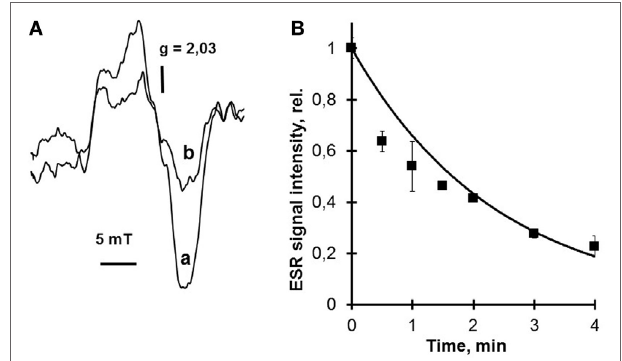
FigURe 1 | Photolysis of cytochrome c nitrosyl complexes. This figure proves the photosensitivity of heme nitrosyl complexes to low power laser radiation. The electron spin resonance (ESR) signals of cytochrome c nitrosyl complexes before and after He–Cd laser (442 nm) irradiation in the air are presented in this figure. The ESR signal of cytochrome c nitrosyl complex shown in panel (A) completely corresponds to hemoprotein nitrosyl complex signal and has g factor 2.03 (20). Irradiation of cytochrome c nitrosyl complexes by He–Cd laser in the air results in nitrosyl complex photolysis and the corresponding decrease of nitrosyl complex ESR signal (B) . Moreover, nitrosyl complex photolysis is accompanied with free nitric oxide (NO) release (data not shown) (18). To detect the NO release, the nitronyl– nitroxyl spin trap can be used. (A) ESR spectra of cytochrome c nitrosyl complexes. Effects of low power He–Cd (442 nm) laser irradiation: a—no irradiation; b—30 s irradiation. Cytochrome c concentration—0.3 mM. He–Cd laser fluence 230 W/m 2 . (B) Effect of He–Cd laser radiation on the intensity of NO–Cyt c ESR signal. Laser fluence—205 W/m 2 . Cytochrome c concentration—0.3